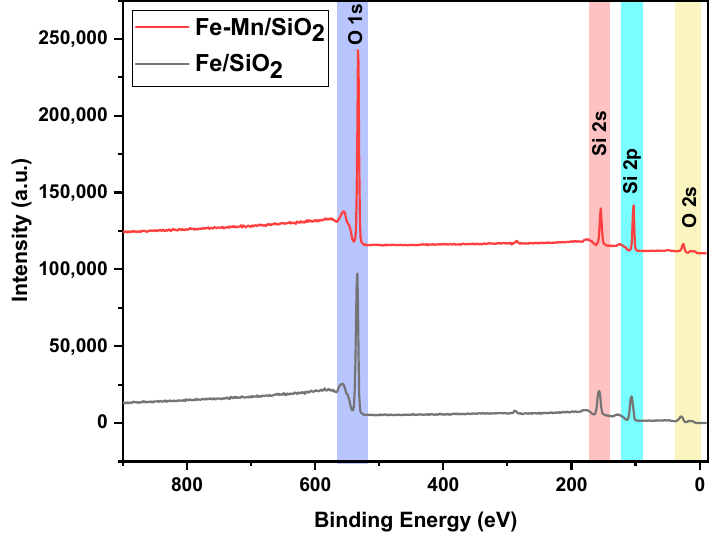
Figure 4. HRXPS full spectrum of nanocomposites.